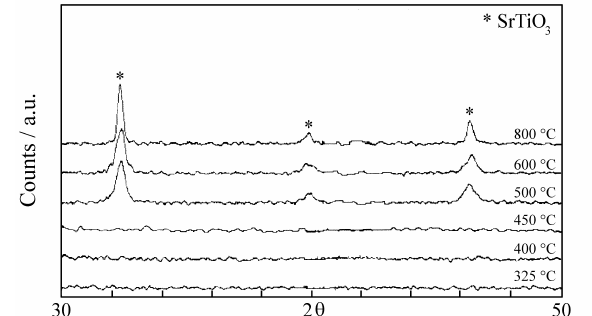
Figure 4. GIXRD patterns of SrTiO 3 thin film on MgO (100) heat treated at different